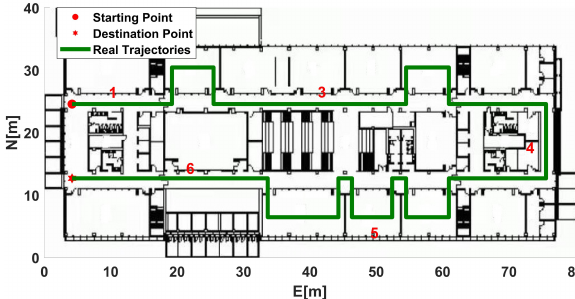
Figure 3: Ichnography and trajectories for the test